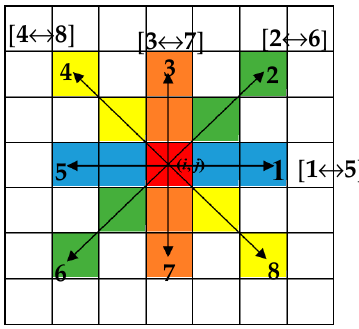
Figure 3. Schematic diagram of search directions and radius for seeds with S = 2, k =